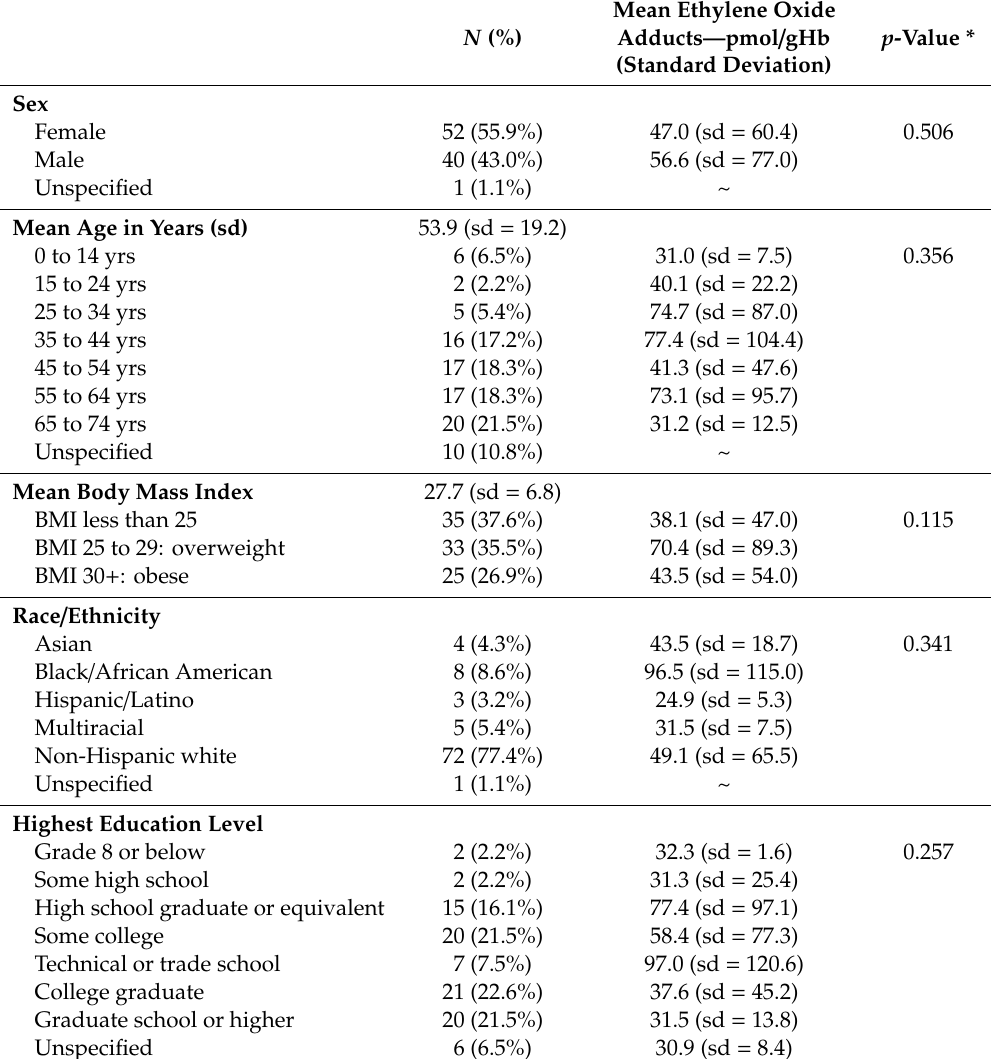
Table 1. Hemoglobin adduct N-2-hydroxyethyl-valine (HbEO adduct) results (in pmol / gmHb) by demographic